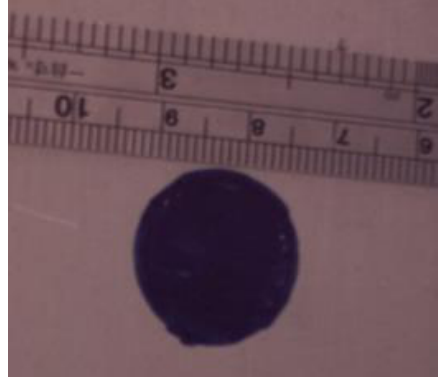
Figure 9. The circular mark on the flat plate.